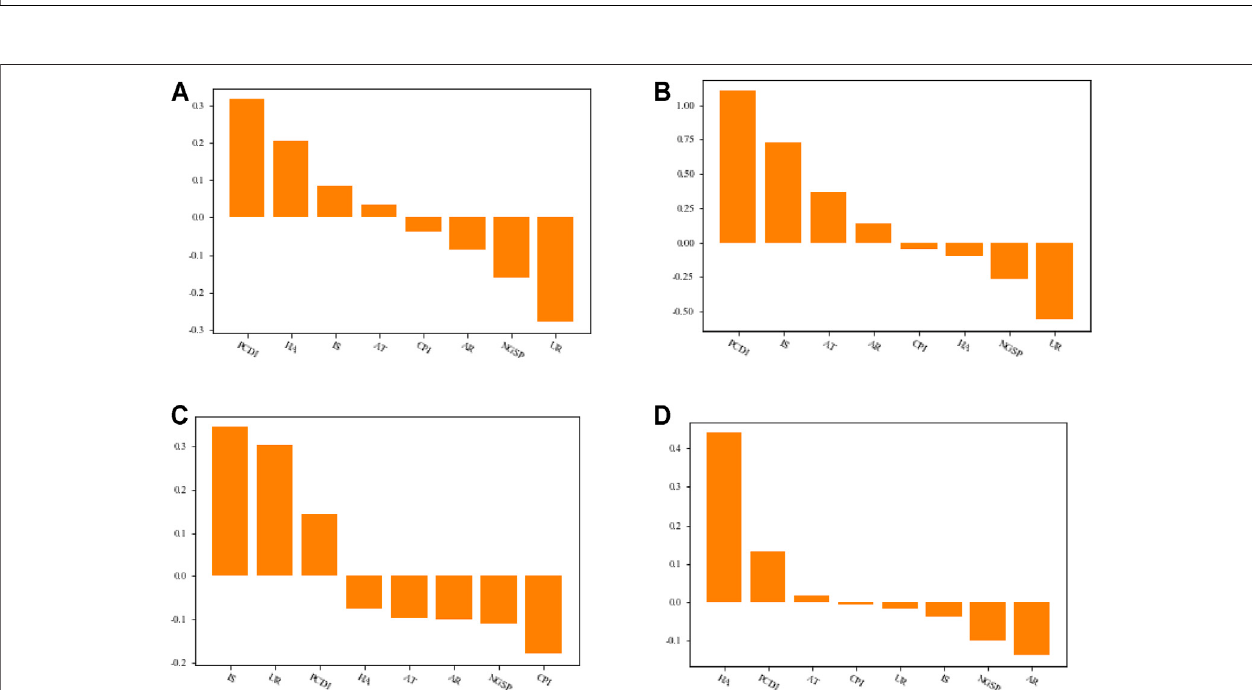
FIGURE 8 | Importance of linear predictor variables for urban household gas